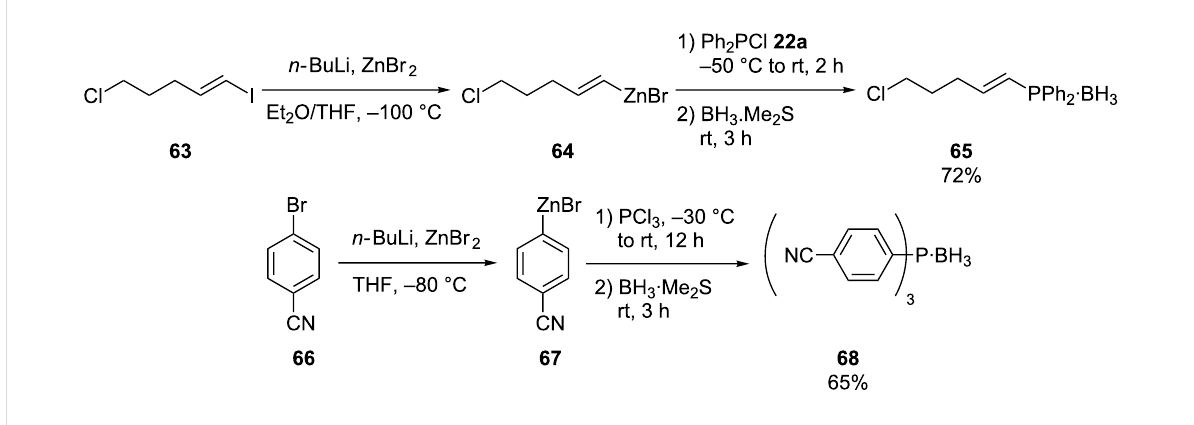
Scheme 17: Preparation of phosphines using zinc organometallics.